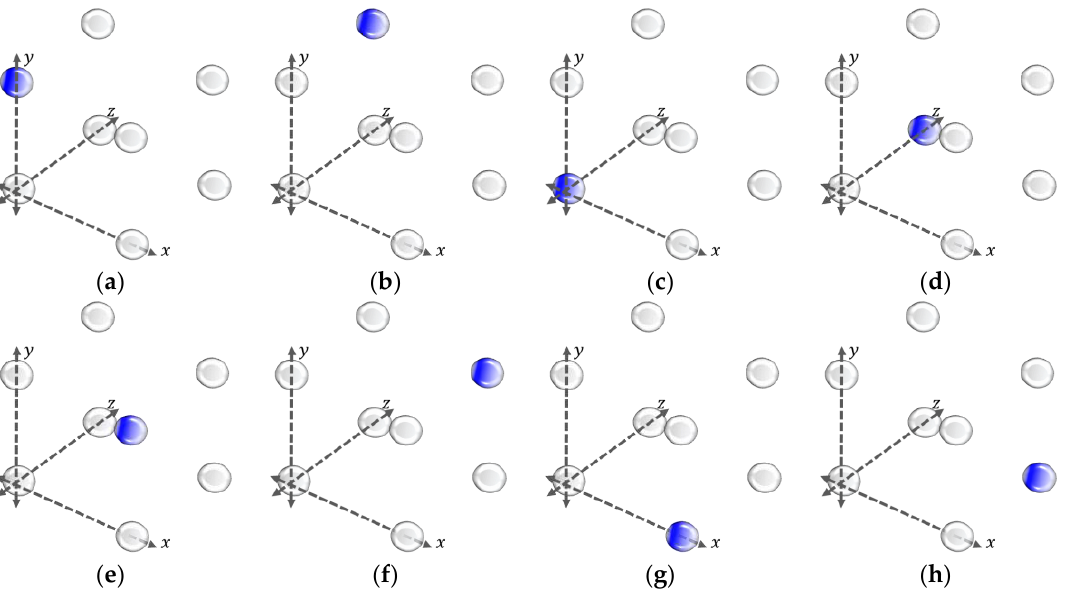
Figure 6. Various position examples where virtual objects were generated (8 cases): ( a ) left-top-front; ( b ) left-top-back; ( c ) left-bottom-front; ( d ) left-bottom-back; ( e ) right-top-front; ( f ) right-top-back; ( g ) right-bottom-front; ( h ) right-bottom-back.